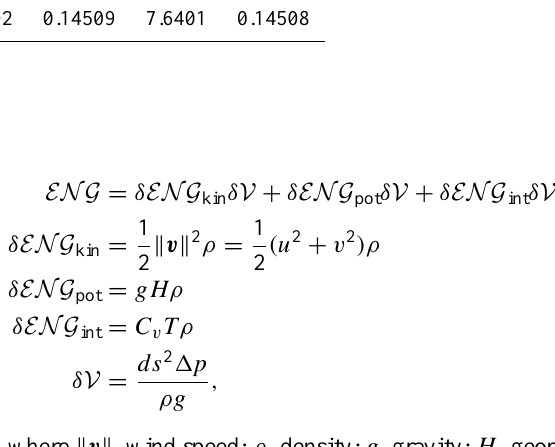
Table 1. Percentage of modifications of the Newtoninan-obtained inverted fields of each anomaly (%) used to modify the initial conditions. Mean absolute variation of the total energy ( MAV ) introduced on the initial conditions (+, increasing case; − , decreasing case). Final values ErPVpTerm ErPVp01 ErPVpHigh % δ ENG % δ ENG % +